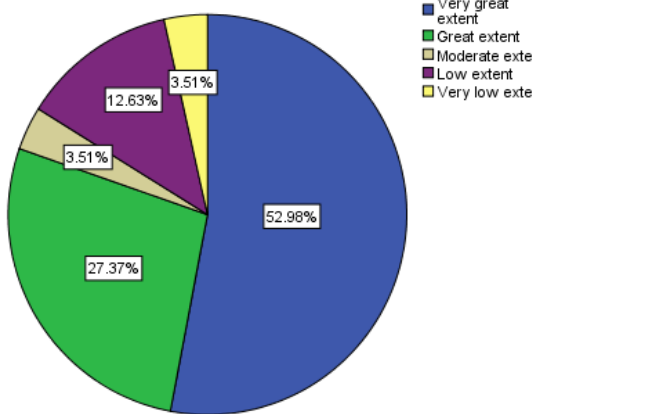
Figure 2. Pie chart showing the responses on self-promotion